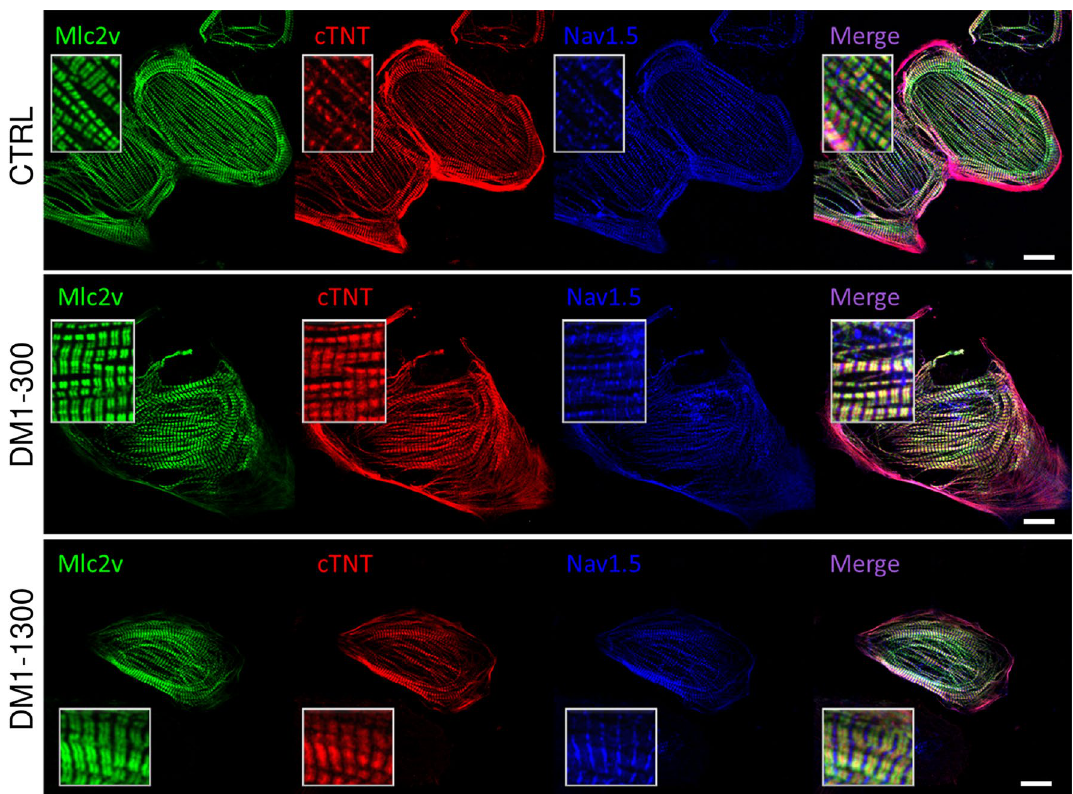
Figure 1. Immunofluorescence staining of cardiac markers in iPSC-CMs after 30 days of maturation. iPSC- CMs from the CTRL individual and the DM1-300 and DM1-1300 patients showed organized contractile proteins, including myosin light chain2v (mlc2v, green staining), cardiac troponin T (cTnT, red staining), and the cardiac sodium channel (NaV1.5, blue staining). The last column shows merged images from mlc2v, cTnT, and NaV1.5. The insets show a zoom-in of the stained proteins. Scale bar: 20 µM. Images were acquired using Zeiss ImagerM2 LSM confocal microscope and processed with ZEN software